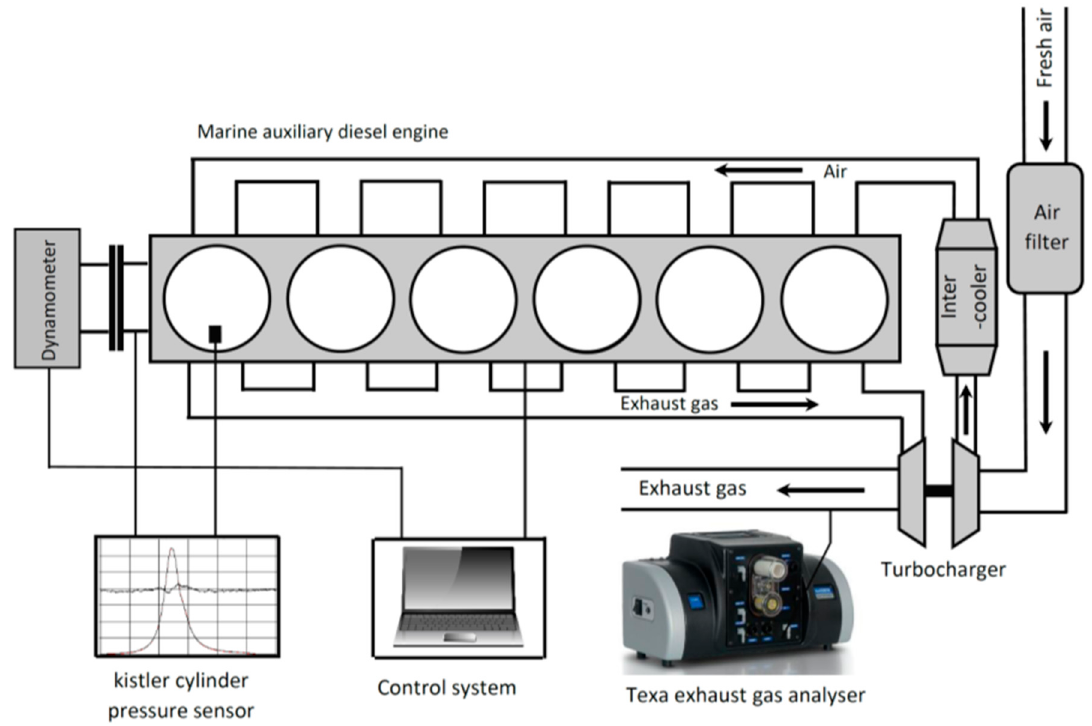
Figure 1. Experimental engine.